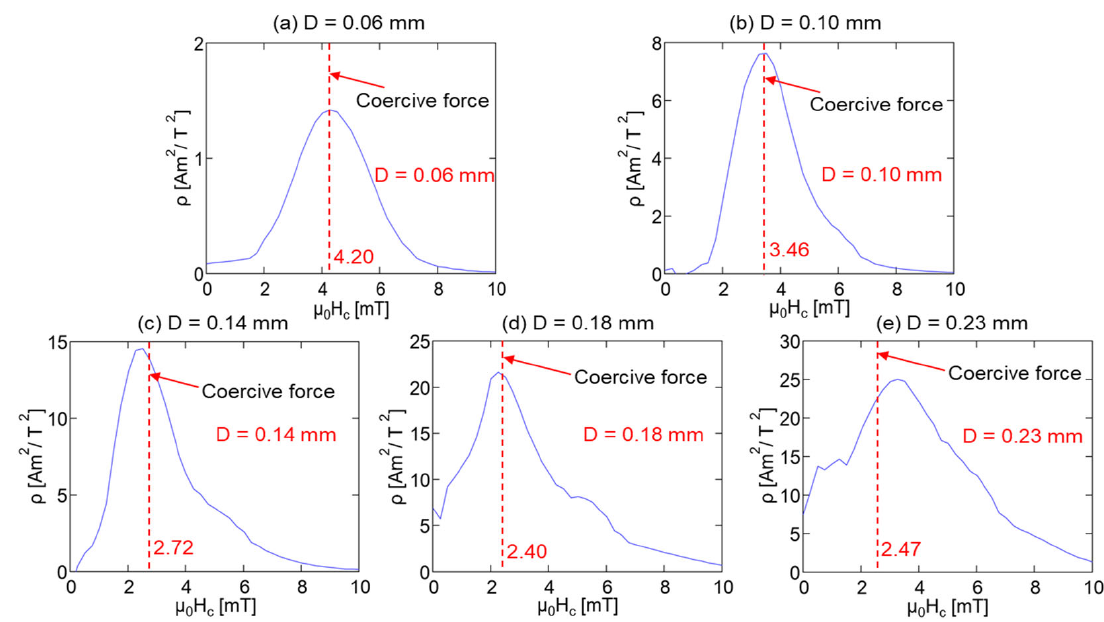
Figure 6. Correlation between maximum of FORC distribution on μ 0 H c axis and coercivity of major hysteresis loop.